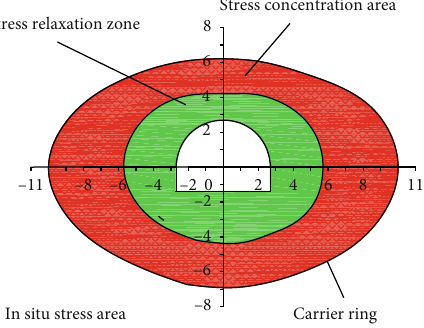
Figure 12: Schematic diagram of